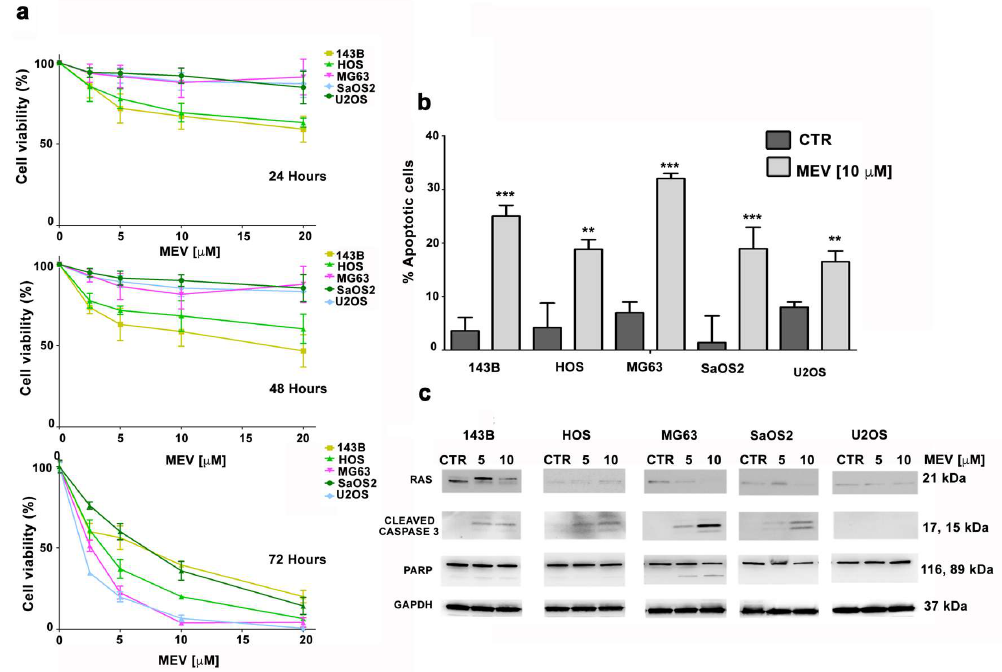
Figure 5. ( a ) MTT assays were performed at 24, 48, and 72 h after treatment with increasing concentrations of mevinolin. At least three independent experiments were performed. ( b ) OS cells were treated with 10 μM of mevinolin for 48 h and an Annexin V-FITC/PI staining assay was performed. The mean ± SD of three separate experiments is shown. CTR: untreated cells. Asterisks indicate statistically significant differences versus untreated (CTR) cells, ** p < 0.01, *** p < 0.001. ( c ) Western blotting analysis of OS cell lines treated with mevinolin (5–10 μM) for 48 h. Interestingly, although 72 h mevinolin treatment reduced cell viability in all OS cell lines, the most significant effect of mevinolin was observed in MG63 cells, expressing the highest prelamin A levels (Figure 5a). Moreover, after long-term mevinolin treatment, the highest increase in the percentage of apoptotic cells was observed in MG63 cell culture (Figure 5b).